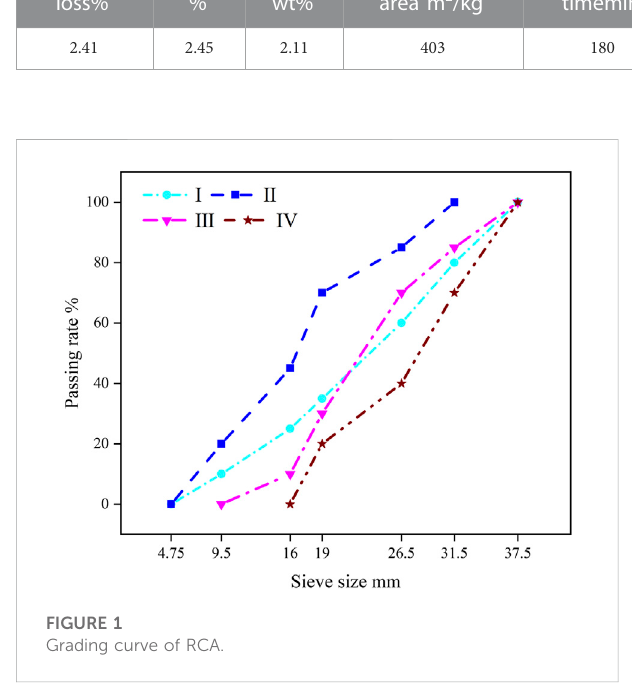
FIGURE 1 Grading curve of